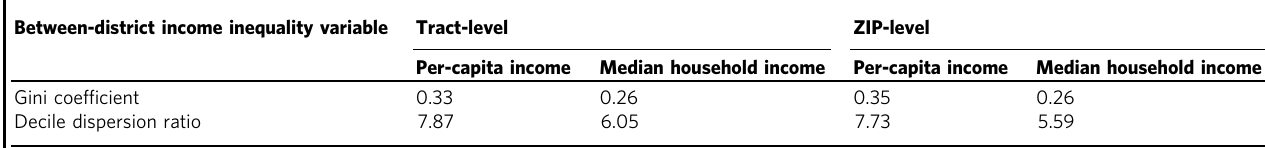
Table 1 Between-district income inequality variables.